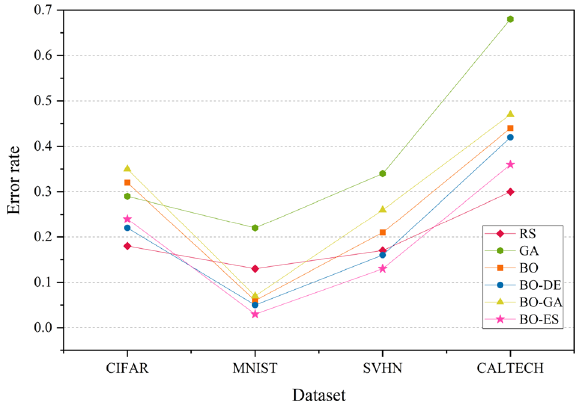
Figure 12. Test set classification error plot of DenseNet model that uses RS, GA, a BO framework for HPO with L-BFGS, BO-DE, BO-GA and BO-ES. The figure depicts the average test error rate across the datasets—CIFAR, MNIST, SVHN and CALTECH (based on 20 iterations). The results are obtained using the Friedman test with a statistical significance of p < 0.01 .